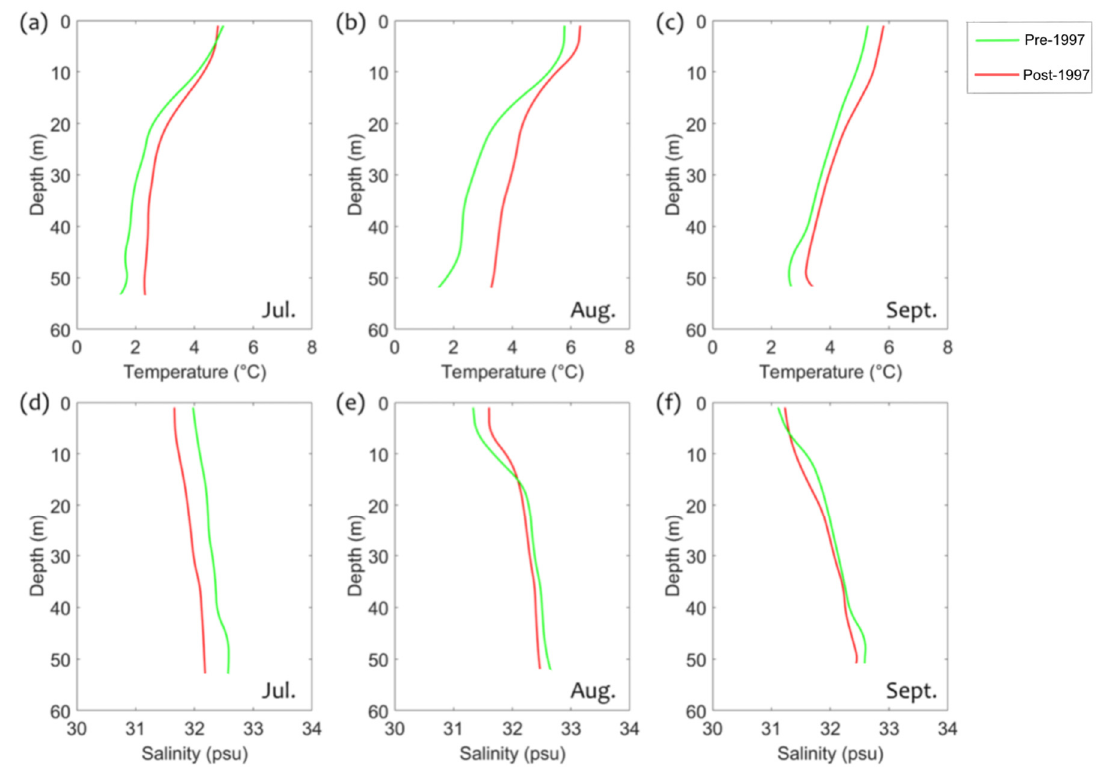
Figure 13. The regional average ( a – c ) T and ( d – f ) S profiles of the southern Chukchi shelf from July to September. The green and red lines represent the average values of the pre- and post-1997 periods, respectively.